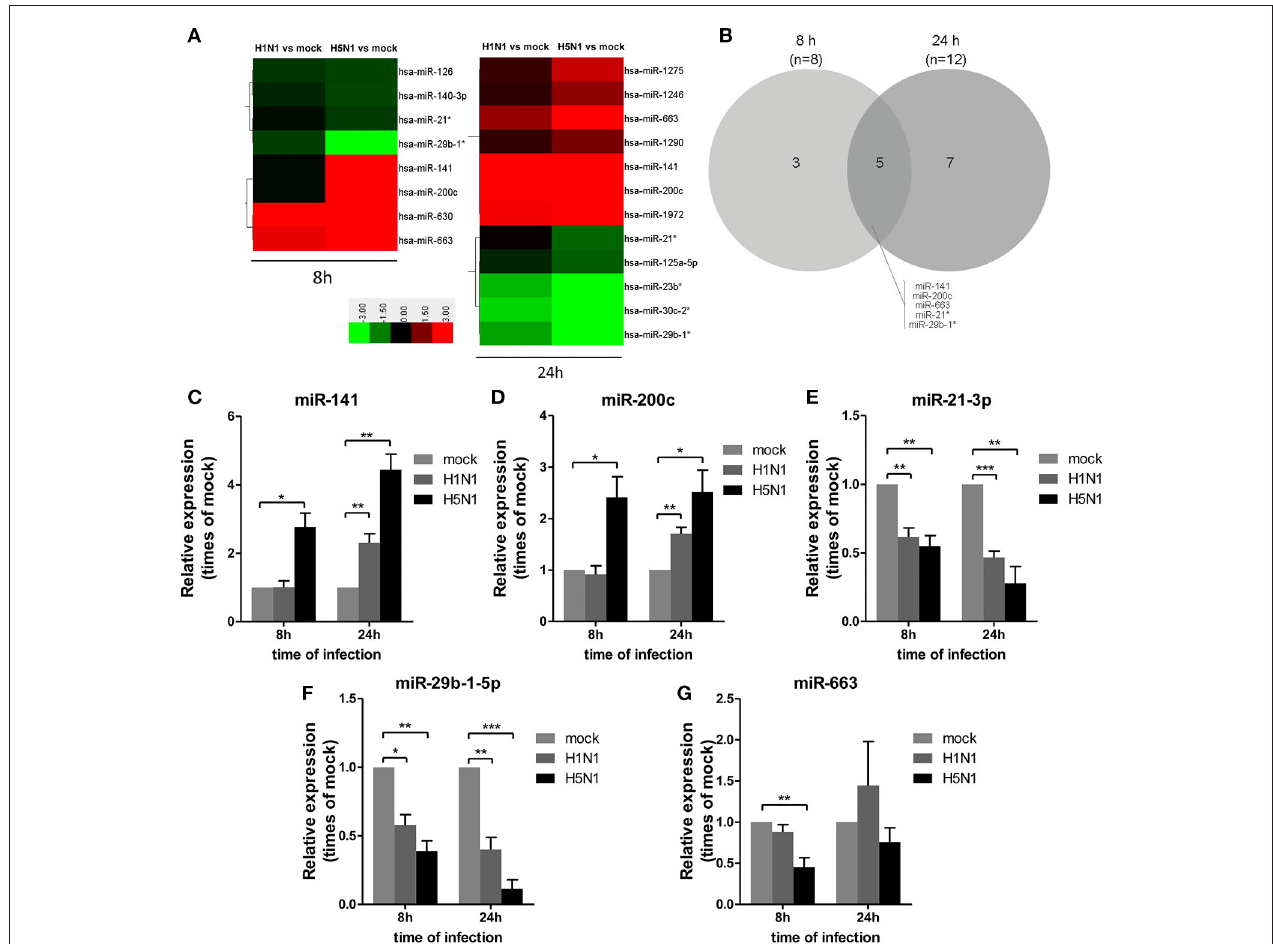
FIGURE 2 | Differential miRNA expression during IAV infection. A549 cells were uninfected or infected with A/Beijing/501/2009 (H1N1) and A/goose/Jilin/hb/2003 (H5N1) at a MOI of 5.0 for the indicated times. (A) Heat map representing miRNAs that were differentially expressed during IAV infection at 8 hpi (left) and 24 hpi (right). Colors indicate the log2 ratios of IAV-infected group vs. uninfected control following the specified scale. (B) Venn diagram of differentially expressed miRNAs during IAV infection at 8 hpi vs. 24 hpi. (C–G) miRNAs from (A) were confirmed at the indicated time points by real-time qPCR analysis. Expression levels of indicated miRNAs were normalized to that of U6 and relative to mock-infected cells. Data are the mean ± SD from four independent experiments. * P < 0.05, ** P < 0.01 and *** P < 0.001 by one-way